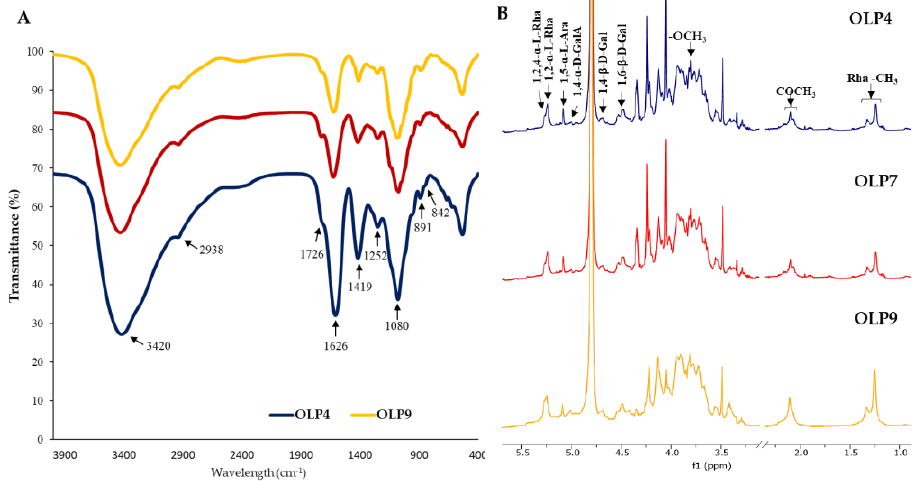
Figure 1. FTIR ( A ) and 1 H NMR ( B ) spectra of polysaccharides from okra leaves (OLPs).